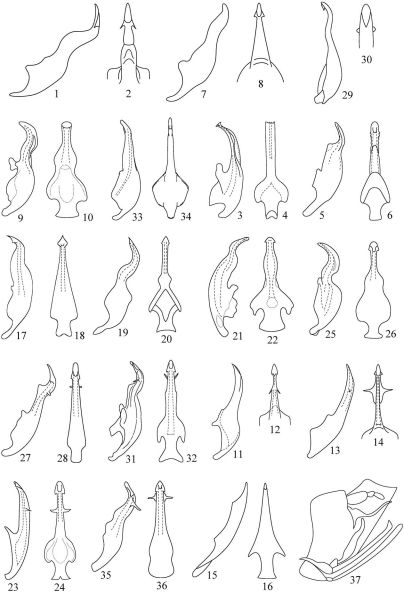
Aedeagus of Pedionis species, lateral view and ventral view. 1, 2 Pedionis astrala Hamilton 3, 4 Pedionis cherraensis Viraktamath 5, 6 Pedionis clypellata Huang & Viraktamath 7, 8 Pedionis contrasta Hamilton 9, 10 Pedionis curvata Viraktamath 11, 12 Pedionis garuda (Distant) 13, 14 Pedionis kagoshimensis (Matsumura) 15, 16 Pedionis koghiensis (Evans) 17, 18 Pedionis lii Zhang & Viraktamath 19, 20 Pedionis mecota Liu & Zhang 21, 22 Pedionis palniensis Viraktamath 23, 24 Pedionis rufoscutallata Huang & Viraktamath 25, 26 Pedionis serrate Viraktamath 27, 28 Pedionis spinata Zhang&Viraktamath 29, 30 Pedionis stigma Kouh 31, 32 Pedionis sumatrana Viraktamath 33, 34 Pedionis venosa Hamilton 35, 36 Pedionis yunnana Zhang & Viraktamath 37 Pedionis minuta (Evans). (1–2, 7–8, 13–14 after Hamilton 1980; 3–4, 31–32 after Viraktamath 1996; 5–6, 23–24 after Huang and Viraktamath 1993; 9–12, 21–22, 25–26 after Viraktamath 1981; 15–16 after Evans 1974; 17–18, 27–28; 35–36 after Zhang and Viraktamath 2010; 19–20 after Liu and Zhang 2003; 29–30 after Kuoh 1987; 33–34 after Okudera 2009; 37 after Evans 1971)